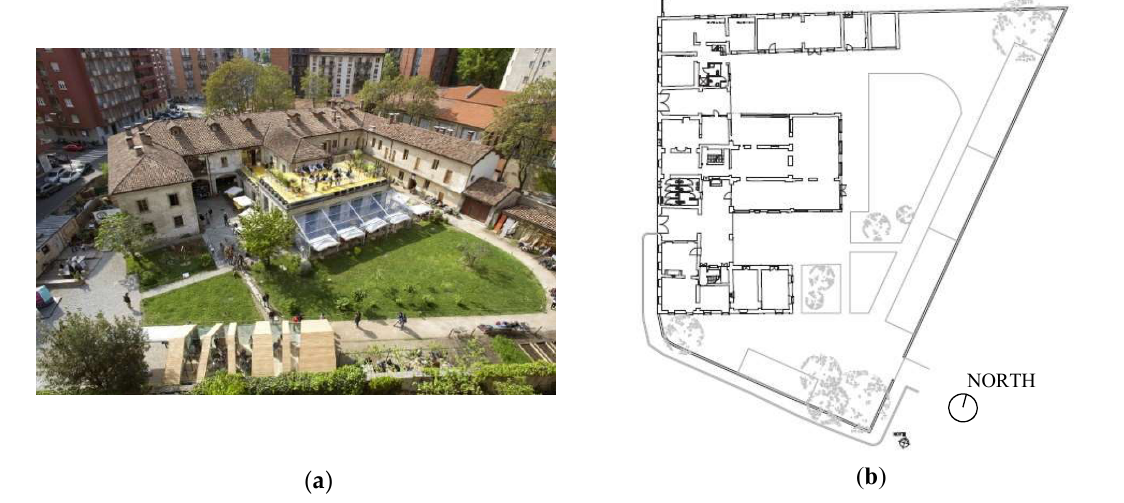
Figure 3. Cascina Cuccagna,(a) overall view and (b) ground floor plan.